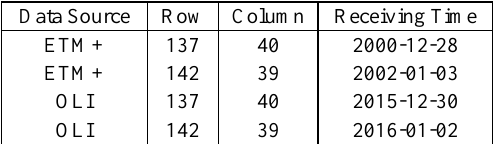
Table 1. Receiving time of remote sensing data and its scene number